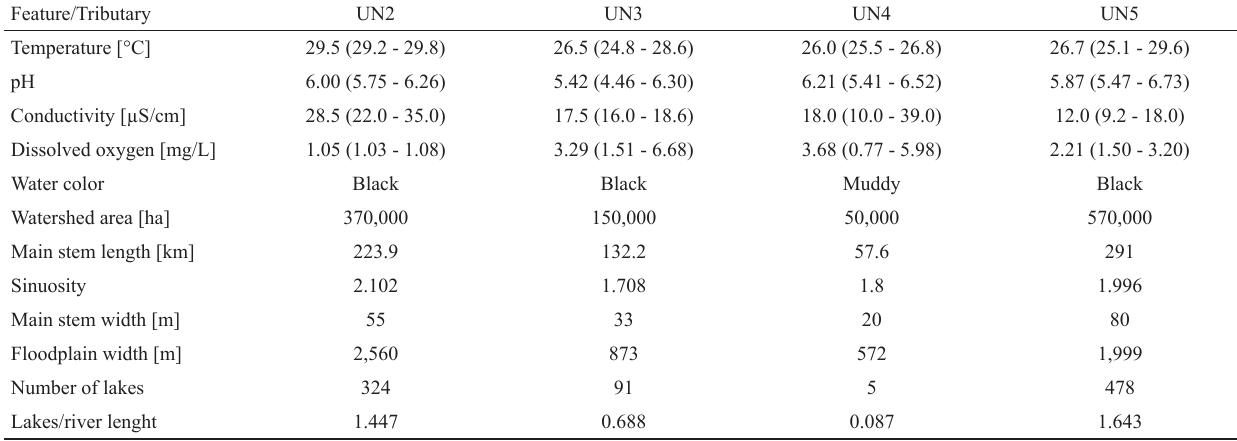
Fig. 1. Map of Unini River basin in Central Brazilian Amazon indicating the location of the four tributaries sampled. UN2 - Preto River; UN3 - Arara River; UN4 - Solimõezinho River; UN5 - Pauini River. Tab. 1. Overview of geomorphological and environmental features recorded in Unini River tributaries during time of specimen collections. Measurements including more than one value are expressed as the average and